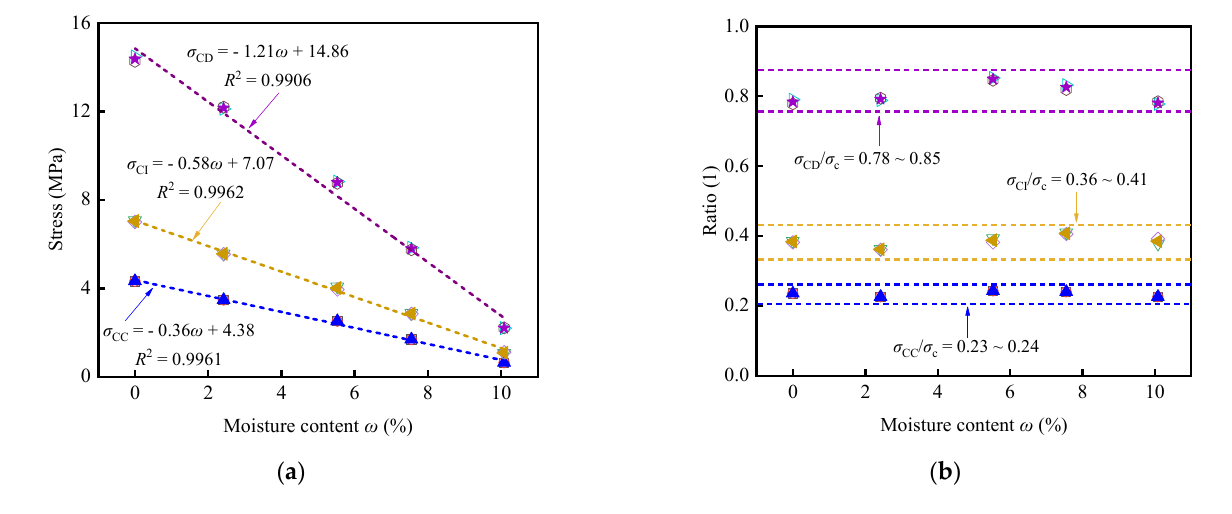
Figure 16. The average crack CC threshold, CI threshold, and CD threshold when the inclination angle was 10 ◦ : ( a ) the CC threshold, CI threshold, and CD threshold changed with the moisture content; ( b ) the ratio of the CC threshold, CI threshold, and CD threshold to σ c varied with the moisture